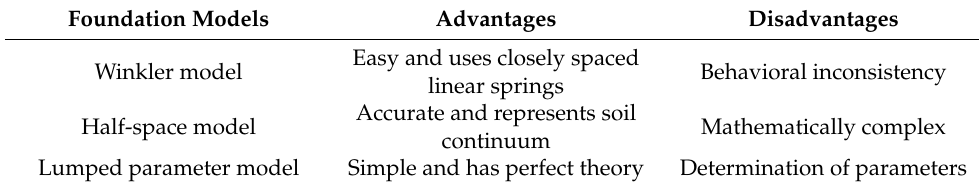
Table 1. A comparison of characteristics of different foundation